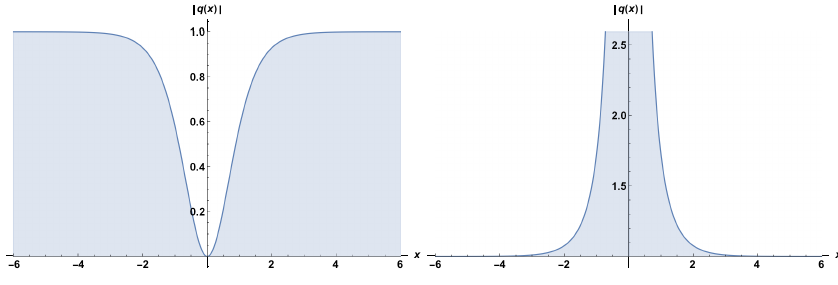
Figure 2. Profiles of stationary dark and singular solitons,